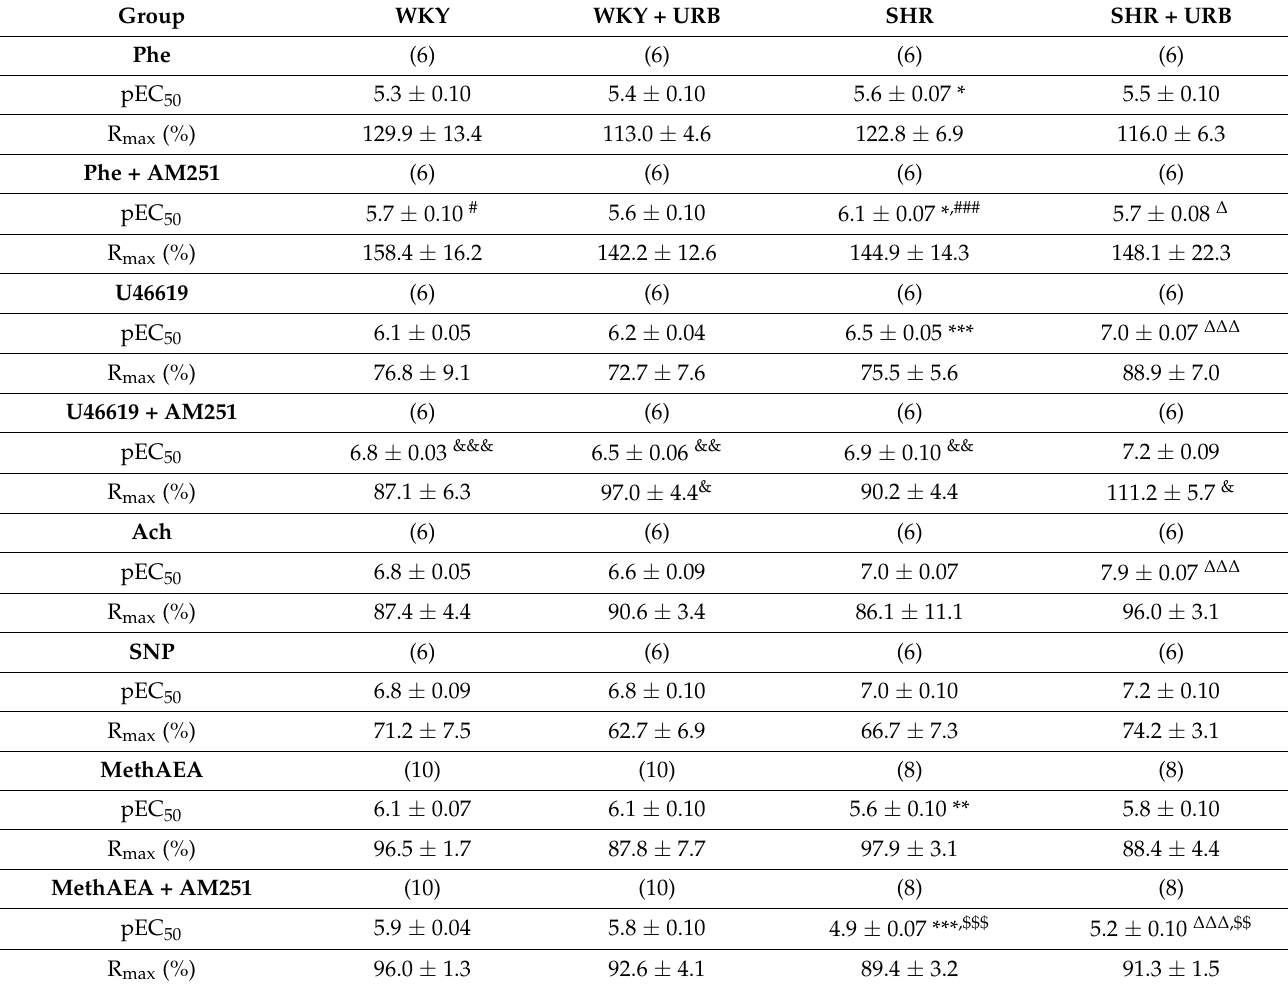
Table 1. The influence of AM251 (1 µ M) on the vasoconstriction to phenylephrine (Phe), thromboxane analog U46619 and vasorelaxation to methanandamide (MethAEA) and vasorelaxant effects of acetylcholine (Ach) and sodium nitroprusside (SNP) in the endothelium-intact isolated small mesenteric G3 arteries from normotensive rats: control (WKY) and URB597- treated (WKY + URB), or hypertensive rats: (SHR) and URB597-treated (SHR +